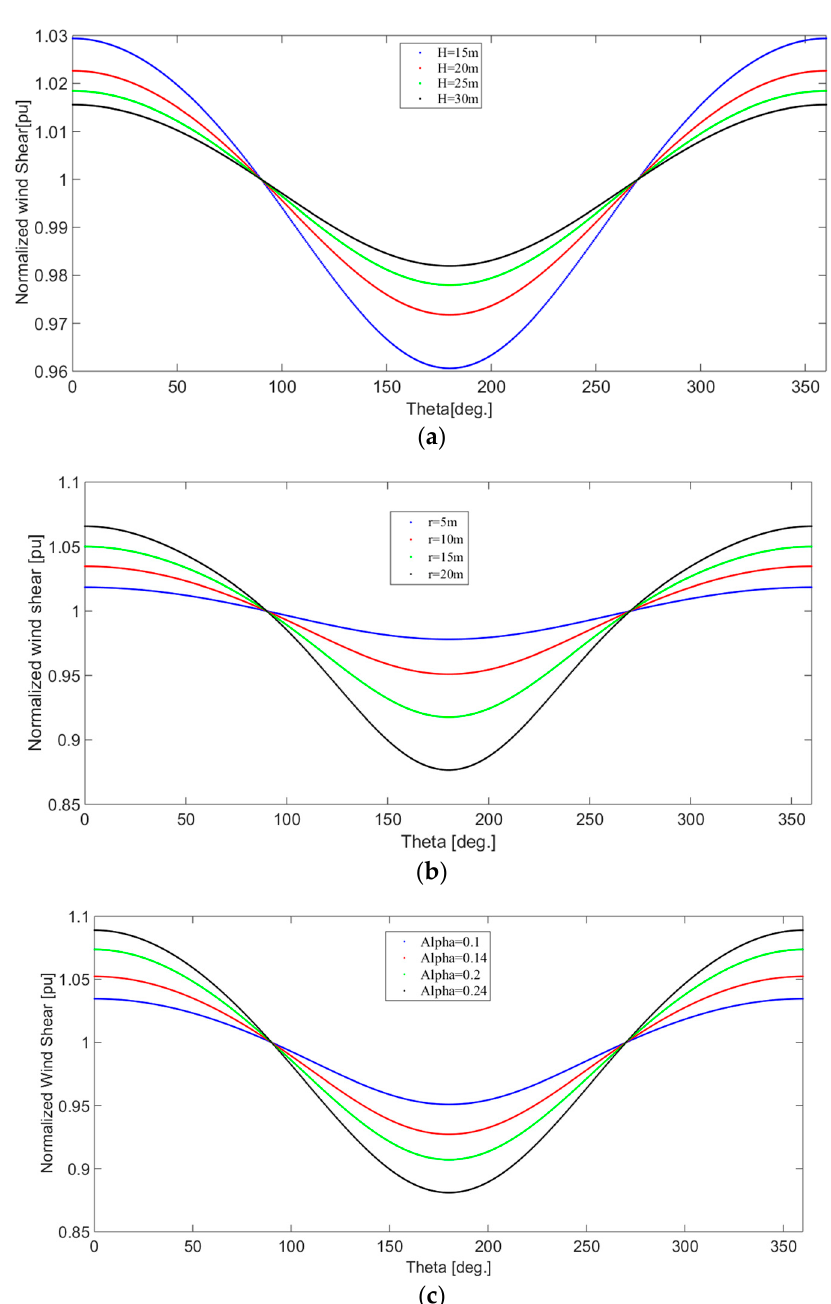
Figure 3. Wind shear comparison with parameter adjustment: ( a ) Wind shear by rotor radius; ( b ) wind shear by hub height; ( c ) wind shear with wind shear index.